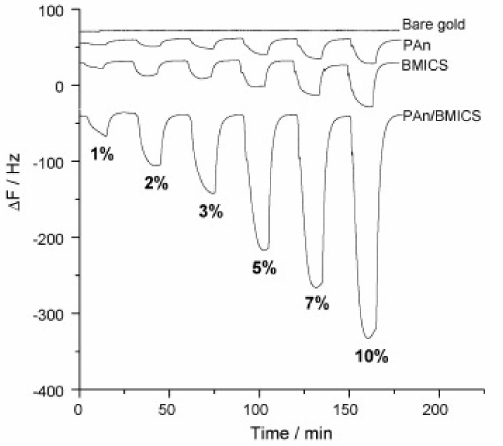
Figure 7. Frequency changes upon methane absorption and desorption on bare gold, PAn, BMICS, and emeraldine salt PAn/BMICS-coated QCM devices at room temperature. Figure is reproduced from